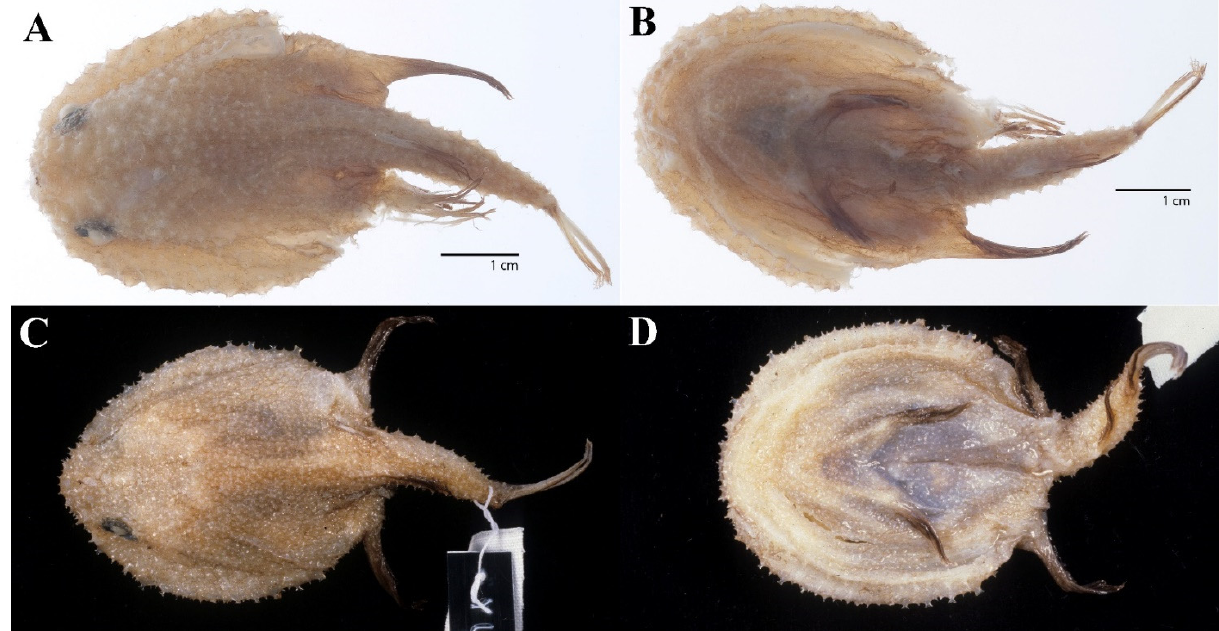
Figure 34. Halieutopsis stellifera (Smith and Radcliffe, 1912). ( A , B ). Holotype, USNM 70273, 67.9 mm SL, photos by S. Raredon, courtesy of USNM. ( C , D ). BSKU 29775, 64.6 mm SL, photos by M. G. Bradbury. A , C . Dorsal view. B , D . Ventral view.